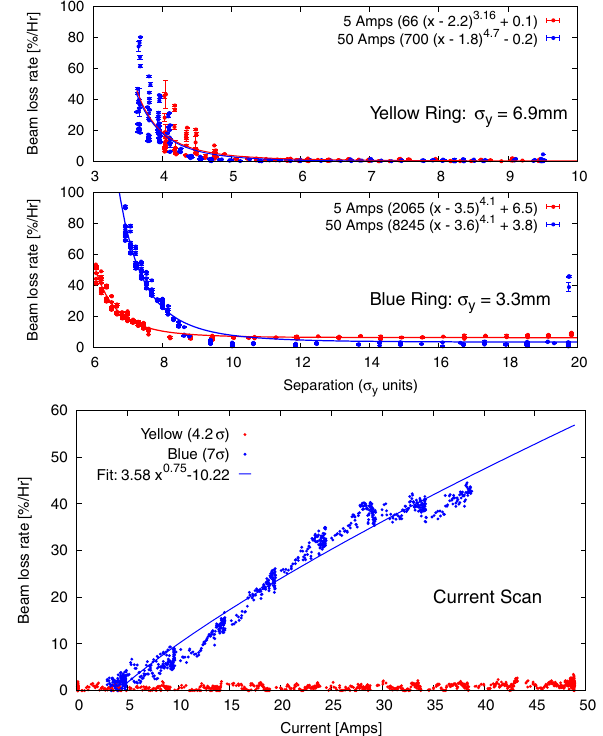
FIG. 13. Top: Beam loss as a function of the DC wire separa- tion to the Blue and the Yellow beams at 5 A and 50 A. Bottom: Beam loss due to a current scan in the DC wire fixed at a given distance from the beam. Solid lines in all plots show a power law fit to the losses.